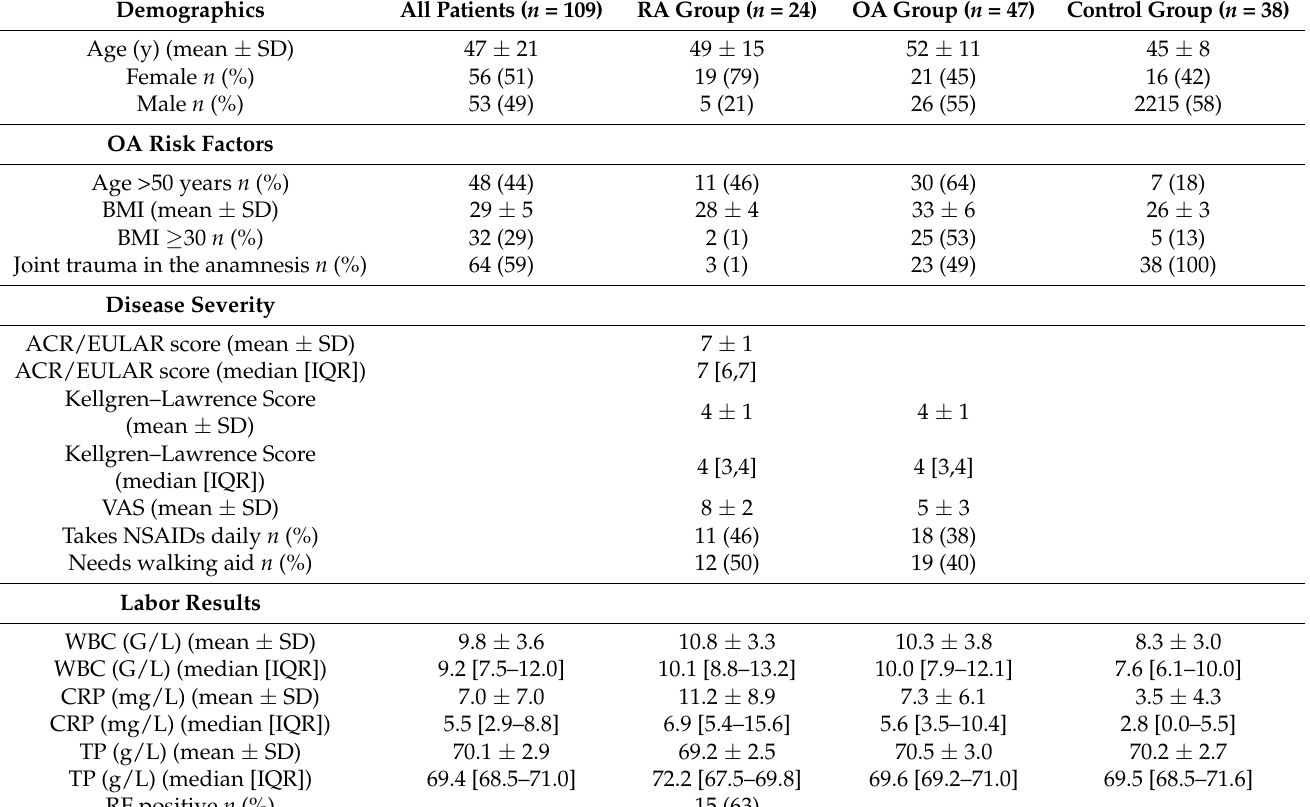
Table 1. Patient characteristics. The patients were graded according to the Kellgren–Lawrence classification by two independent orthopedic trauma surgeons. VAS refers to the chronic pain in the joint affected by OA. Acute pain due to acute trauma was not considered. Daily use of NSAIDs refers to habitual drug intake. Taking NSAIDs for a short period after trauma was not regarded as daily use. Crutches, rollators, and wheelchairs were categorized as walking aids. Labor parameters were measured prior to joint surgery. CRP levels were not measurable under 2 mg/L, thus a CRP < 2 mg/L was considered as 0. OA = osteoarthritis; SD = standard deviation; BMI = body mass index; IQR = interquartile range; VAS = visual analog scale; ACR/EULAR = American College of Rheumatology/European League Against Rheumatism; NSAID = non-steroidal anti-inflammatory drug; WBC = white blood cell; CRP = C-reactive protein; TP = total protein; NIDDM = non-insulin dependent diabetes mellitus; and IDDM = insulin dependent diabetes